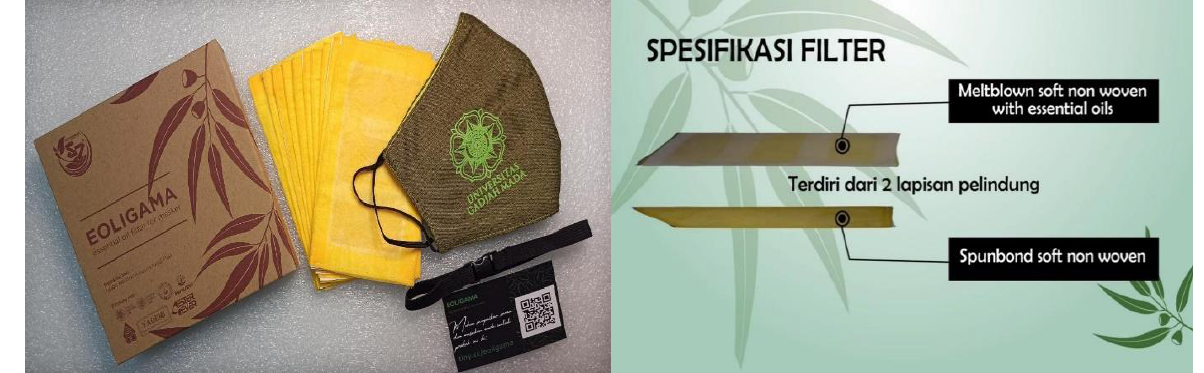
Figure 3. Cajuput essential oil filter for face mask.